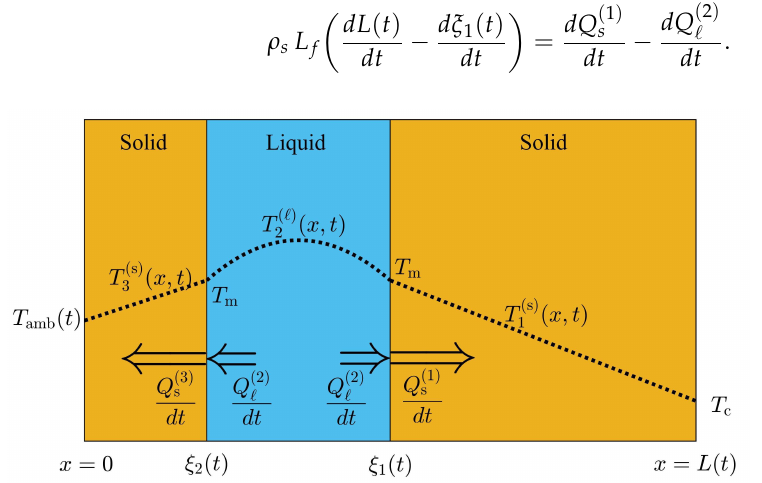
Figure 2. Regions 1, 2 and 3 represent a solid-liquid-solid phase configuration with a tem- perature distribution T